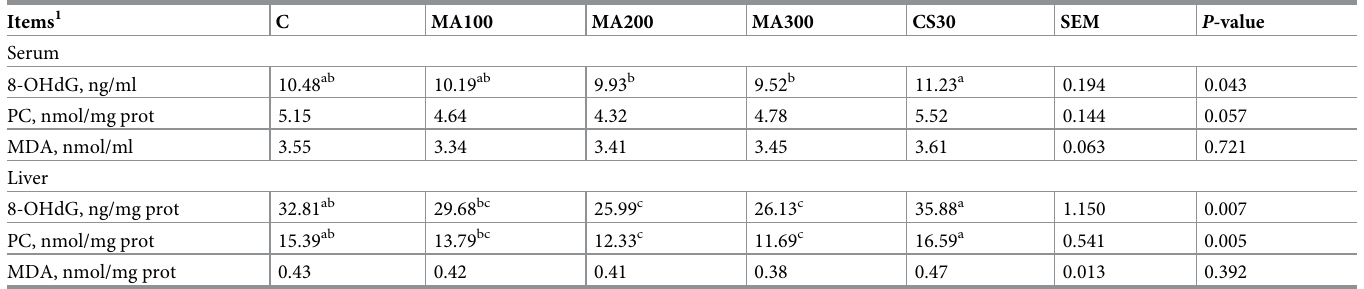
Table 7. Effect of different magnolol levels in diet on peroxide biomarkers of 28 d Linwu ducks. Items 1